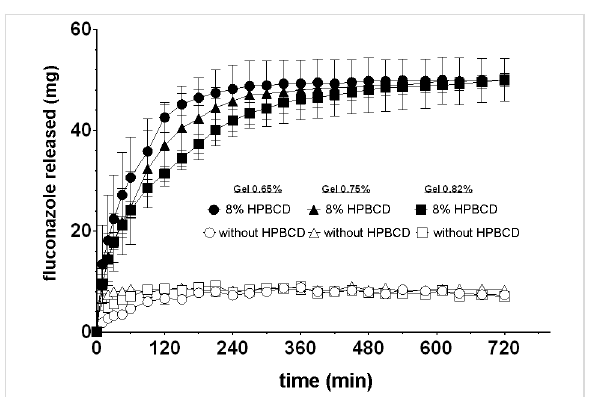
Figure 7: Release profiles of fluconazole in simulated tear fluid from the gels with (closed symbols) or without (open symbols) HPBCDs and different proportions of polysaccharides (mean ± SEM, n =